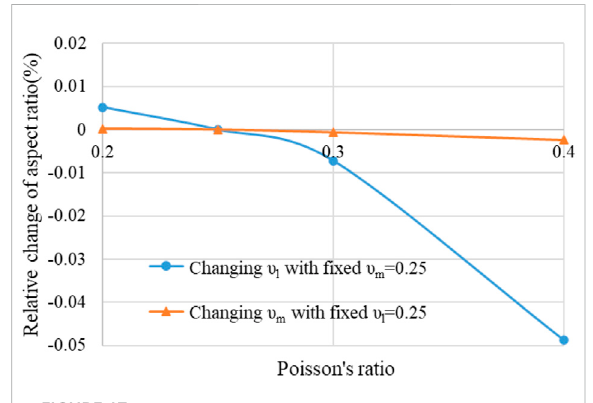
FIGURE 17 Correlations of relative change of aspect ratio and Poisson ’ s